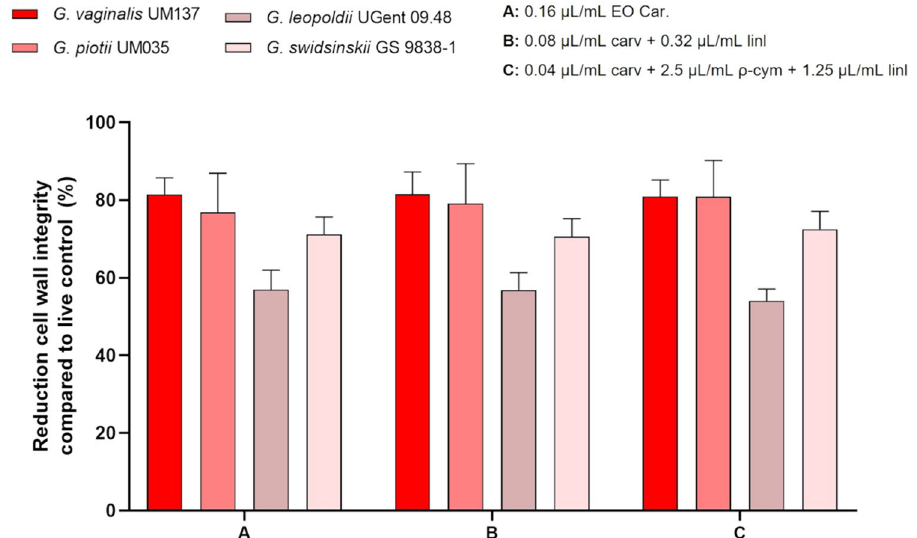
Figure 5. Results from LIVE/DEAD quantitative analysis of G. vaginalis UM137, G. piotii UM035, G. leopoldii UGent 09.48 and G. swidsinskii GS 9838-1 48 h biofilms after the activity of EO Car. and two combinations of compounds. The results are shown in percentage of reduction of cell wall integrity compared to live control. Error bars represent s.d. No statistical differences were found when using a t-test (n = 3) comparing the different conditions within the same tested species. All conditions are statistically different from the